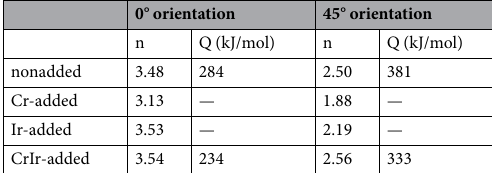
Table 1. The stress exponent n and activation energy Q for creep deformation for the various (Mo 0.85 Nb 0.15 )Si 2 - based two-phase crystals evaluated in this